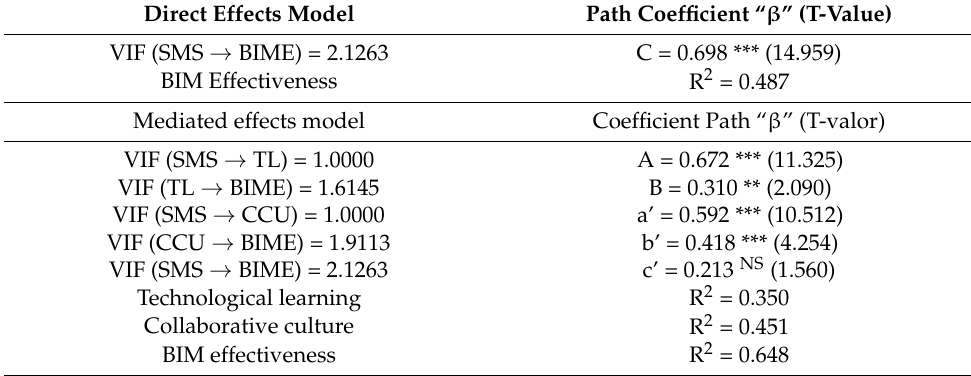
Table 4. Structural model results.